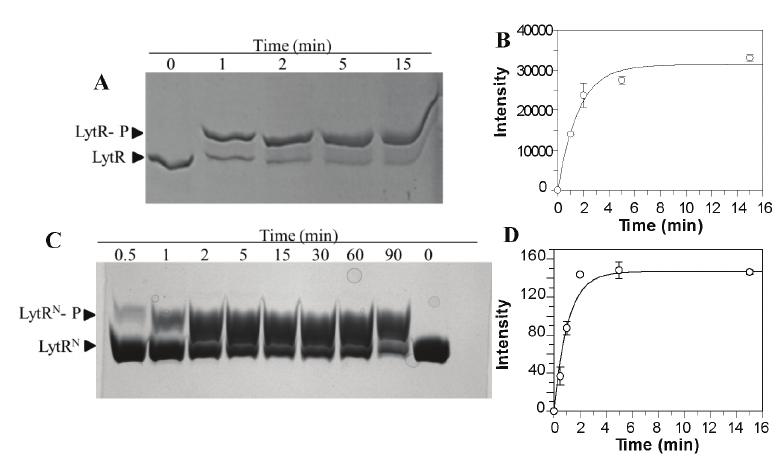
Figure 4. Phosphorylation of LytR and LytR N by acetyl phosphate. ( A ) LytR at 10 µM was phosphorylated by acetyl phosphate (50 mM) in PB for 1 h at 37 o C. ( B ) Quantitative analysis of the data using NIH ImageJ (Dataset 2) The data were fitted using Origin software to pseudo first order equation (1) to calculate the rate constant. Errors are the standard deviation from two independent trials. ( C ) LytR N at 20 µM was phosphorylated by acetyl phosphate (50 mM) in PB buffer at 37 o C and reactions were quenched at various time intervals. The phosphorylated proteins were separated from the unphosphorylated protein by 15% Phos-tag gel. The gels were stained with Coomassie blue to view the protein bands. ( D ) Quantitative analysis of the data using NIH ImageJ. The data were fitted using Origin software to pseudo first order equation (1) to calculate the rate constant. Errors are the standard deviation from two independent trials (Dataset 3).